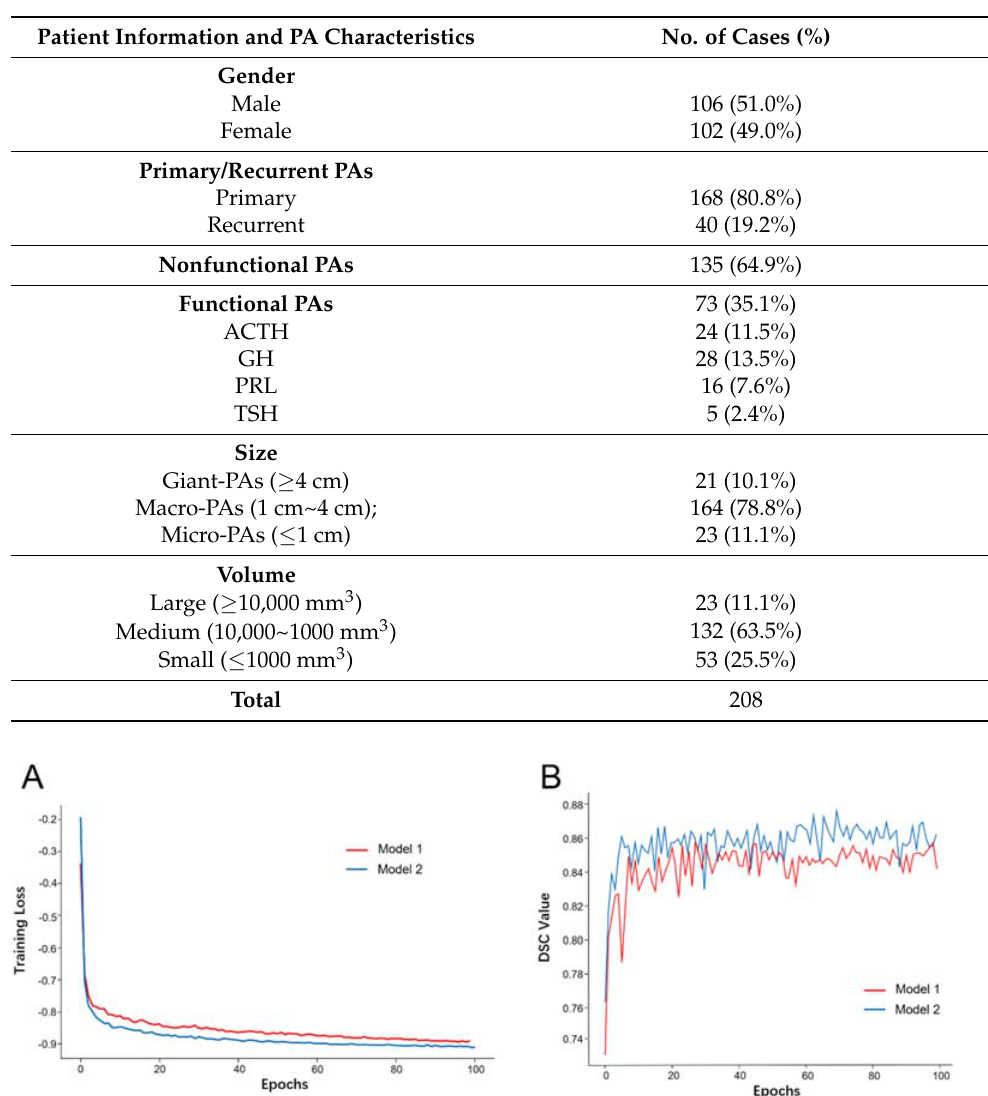
Table 1. Data information of patients and pituitary adenomas (PAs) in the Phase 1.